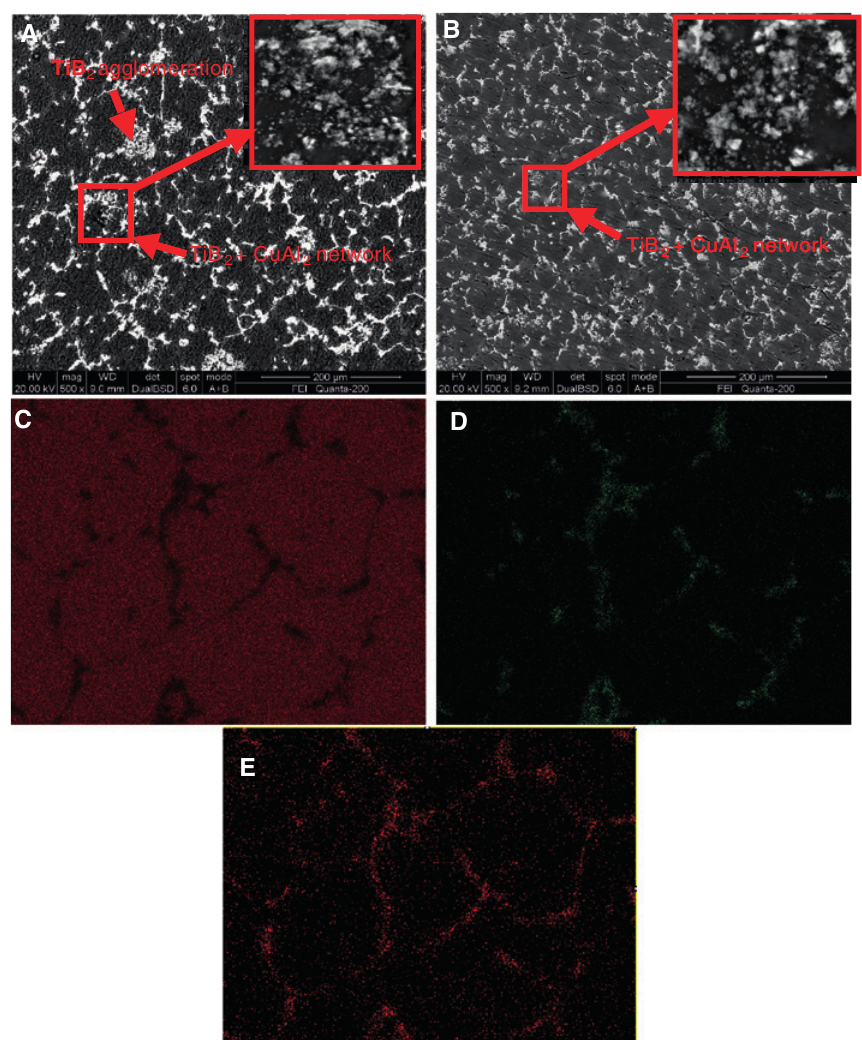
/Al composites. (A) 1.7TiB 2 /Al-4.5Cu 2